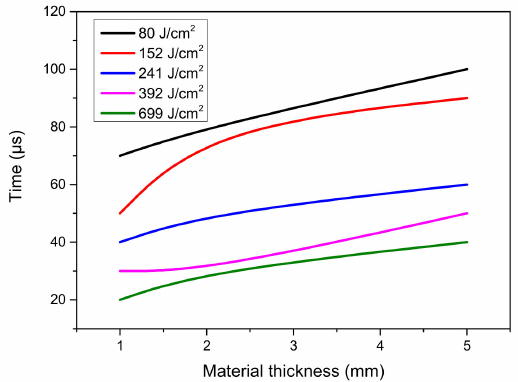
Figure 3. The relationship between the temperature rise, time of laser irradiate CFRP surface, and the thickness of the material under the experimental condition of single pulse ( τ p = 1 ms).